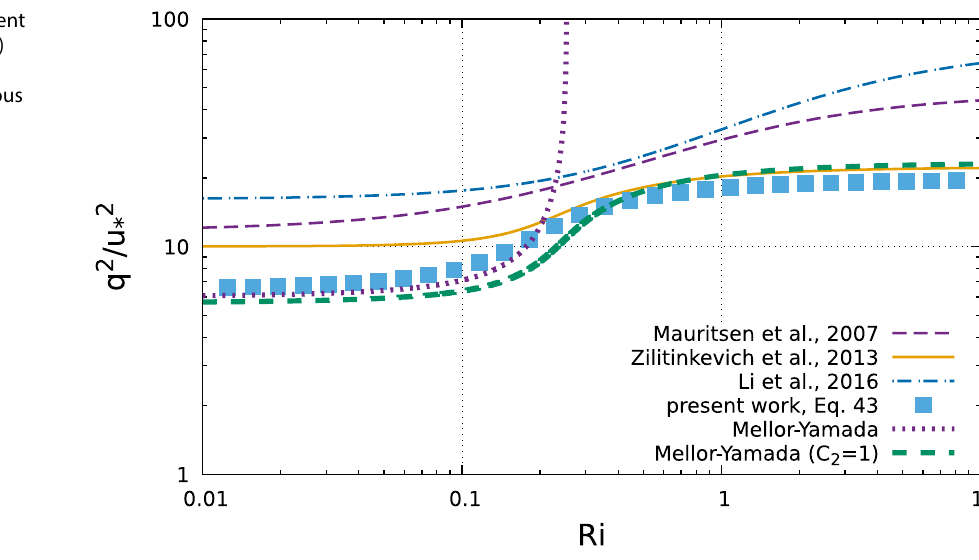
Fig. 7 Blue squares: turbulent kinetic energy from Eq. (43) as function of Ri . Coloured lines: expression from various